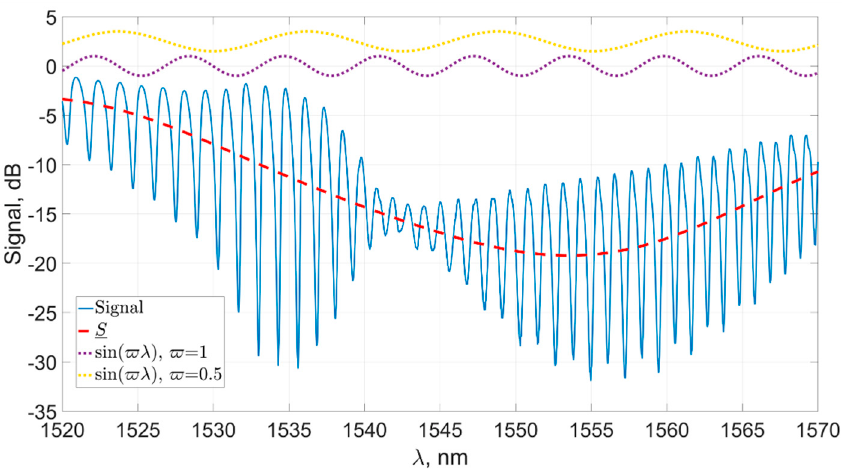
Figure 7. The original signal (solid) and its component S , filtered in the process of signal alignment with the horizontal axis (dashed), and components with generalized frequencies (cid:36) = 0.5 and (cid:36) = 1 (dotted).